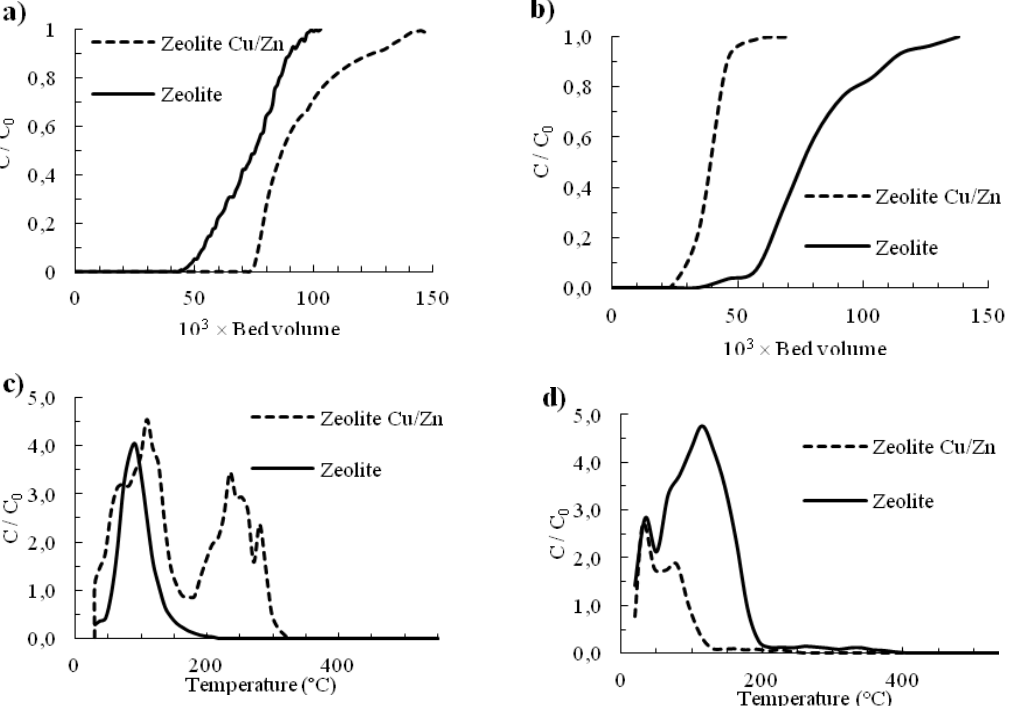
Figure 5. Experimental breakthrough curves for ethylene ( a ) and carbon dioxide ( b ) and desorption curves for ethylene ( c ) and carbon dioxide ( d ) on natural zeolite and modified zeolite with copper and zinc.